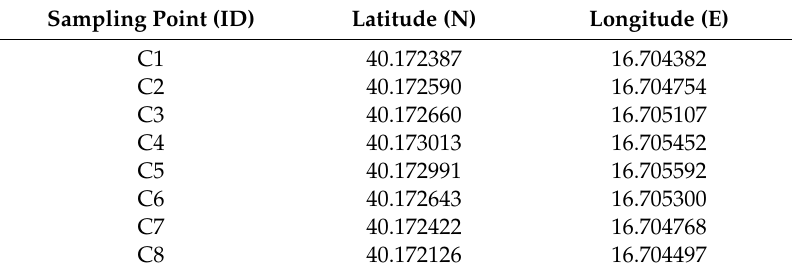
Figure 5. Location of sampling points: effective sampling mesh.